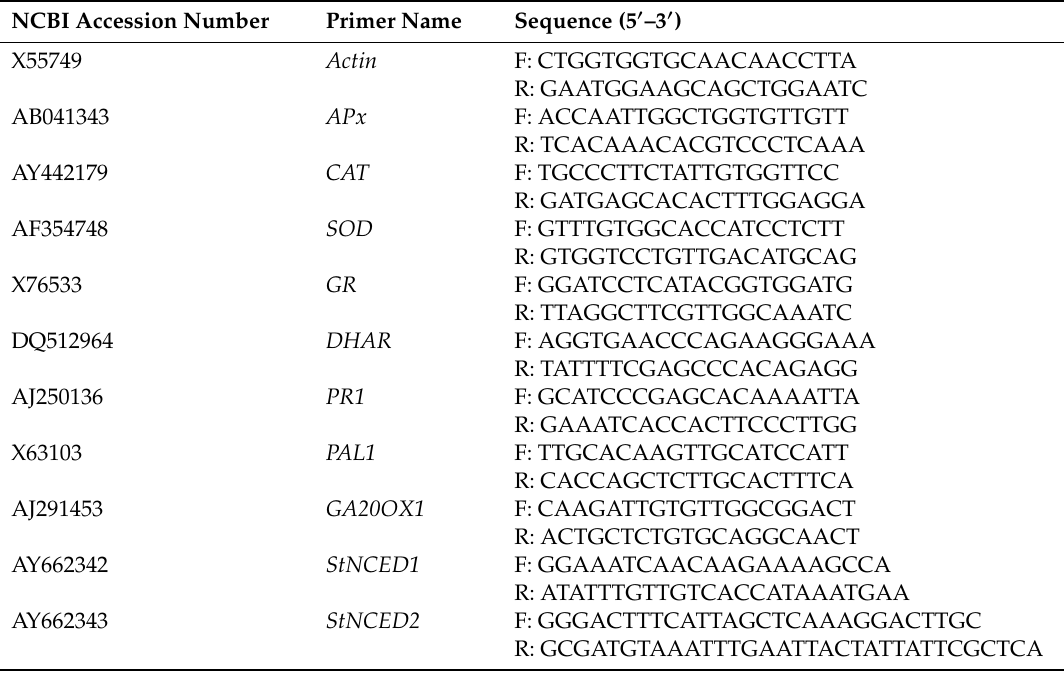
Table 1. List of primers used in the